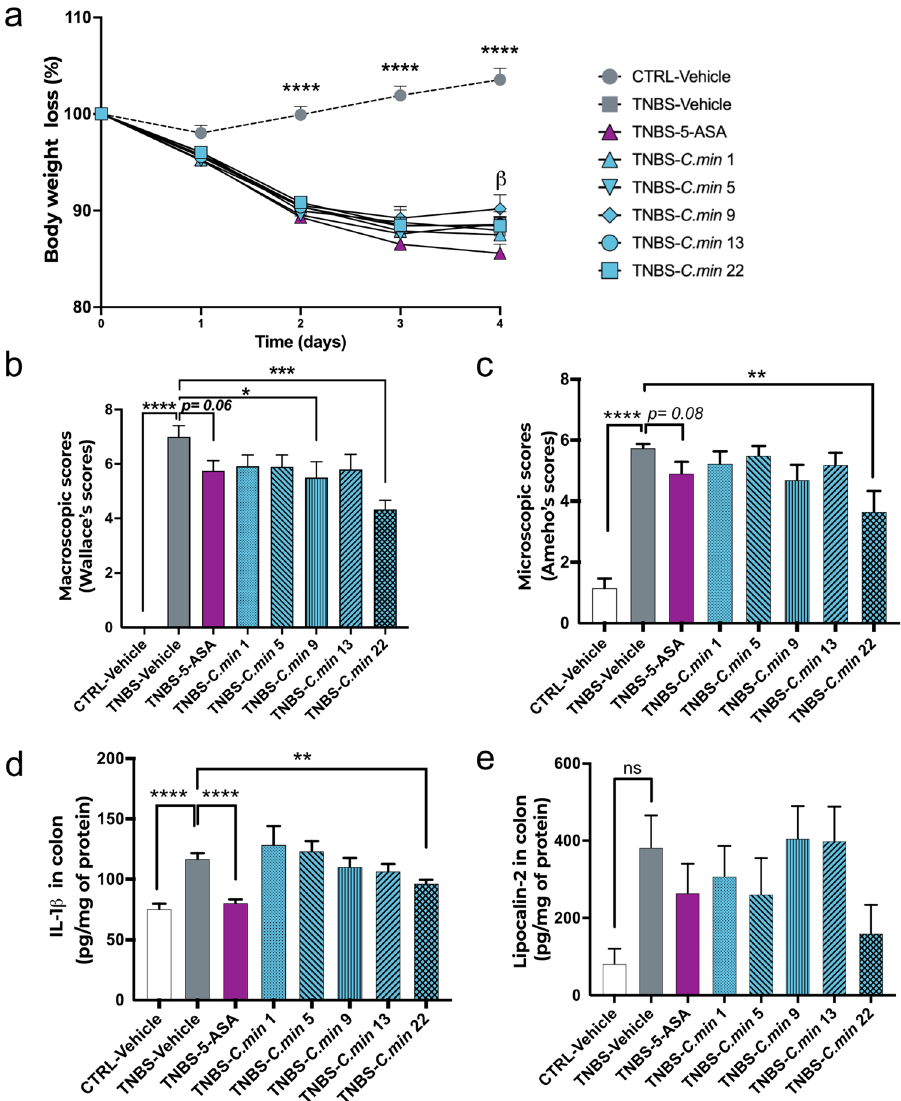
Figure 4. STEP 3 screening in a TNBS-induced rat colitis model. Animals were primed with either a C. minuta strain prepared in PBS-glycerol or the vehicle for 14 days prior TNBS injection. One group receiving the vehicle was also exposed to 5-ASA 150 mg/kg/day in food as a positive control. Body weight loss after TNBS induction ( a ; *: TNBS-Veh vs CTRL-Veh, b : TNBS-Veh vs TNBS-5-ASA). The effect of the different C. minuta strains following inflammation induced by TNBS was assessed by macroscopic score ( b ) and microscopic score ( C ) (minimum n = 6/group). Interleukin-1b ( d ) and lipocalin-2 levels ( e ) were also measured in colonic tissues. Statistics : repeated measures mixed model effect or Kruskal–Wallis with multiple comparisons test ( a ). Unpaired t-test or Mann Whitney test for model validation, one way ANOVA or Kruskall-Wallis with multiple comparisons for treatments effects ( b – e ). *p < 0.05, **p < 0.01, ***p < 0.001, ****p <